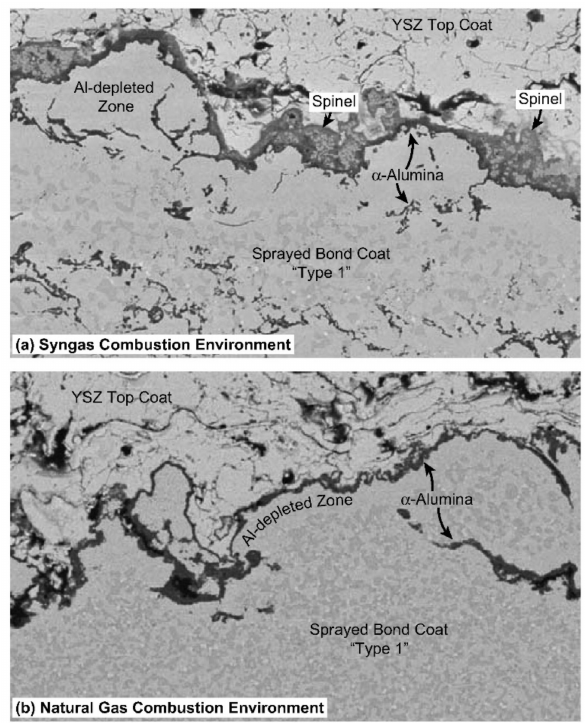
Figure 1. Images of scanning electron microscope (SEM) cross-section near thermal barrier coating (TBC)-bond coat interfaces from field tests of industrial turbine blades. Thermally grown oxide (TGO) develops dissimilarly on equivalent TBC systems when combusting ( a ) using syngas versus ( b ) using natural gas